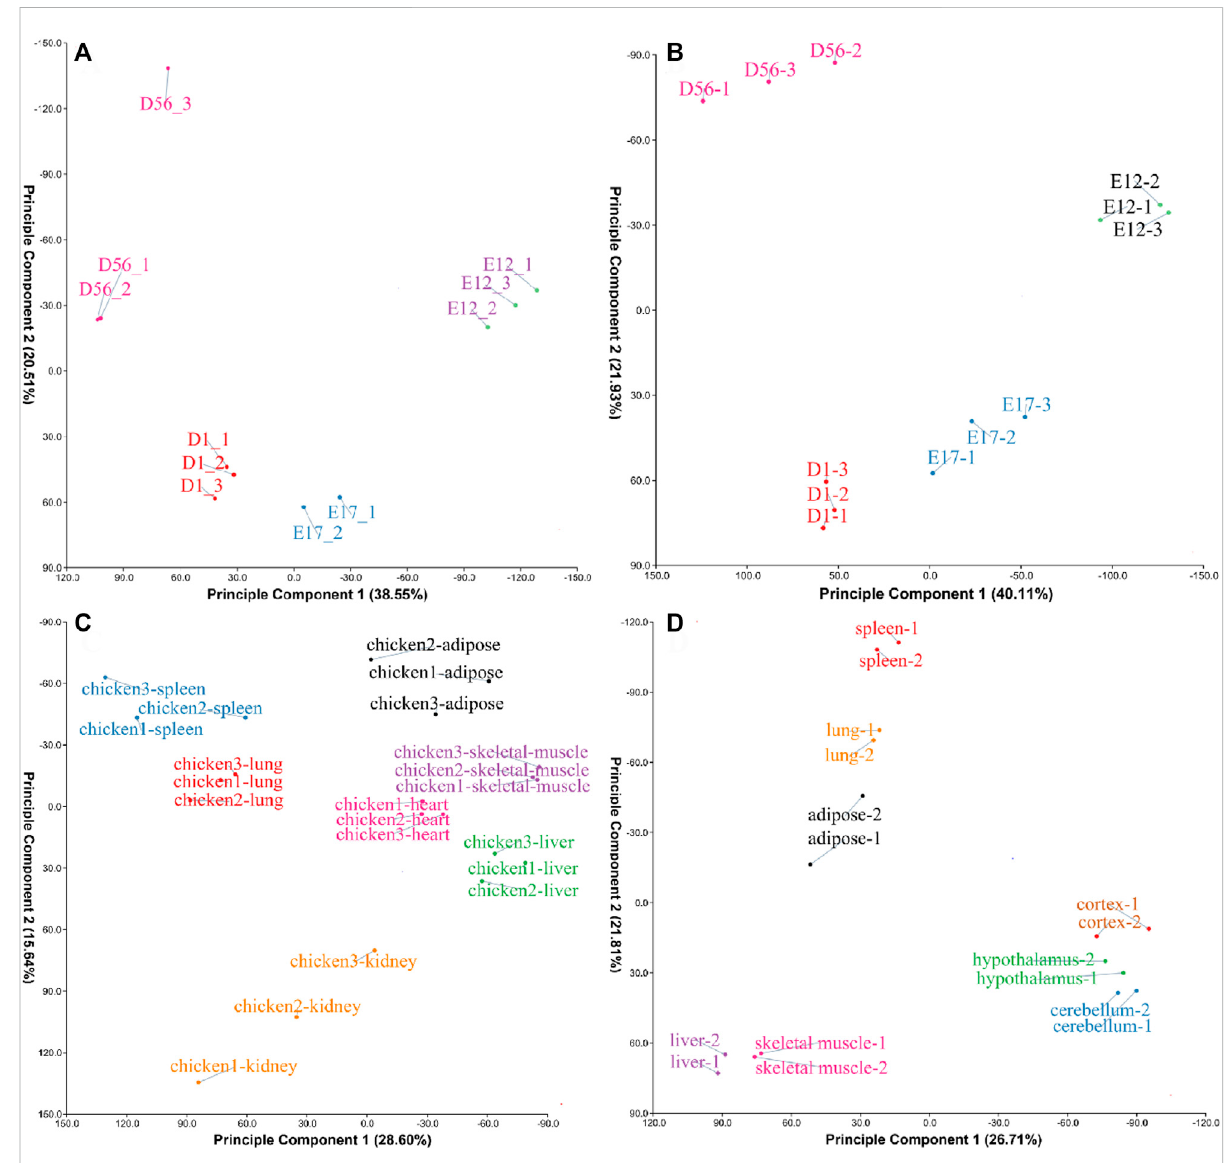
FIGURE 1 Principal component analysis (PCA) of samples from different datasets. (A) The PCA result of the PRJCA001556 dataset; (B) PCA result of the PRJCA001192 dataset; (C) PCA result of the GSE162148 dataset; and (D) PCA result of the PRJNA665193